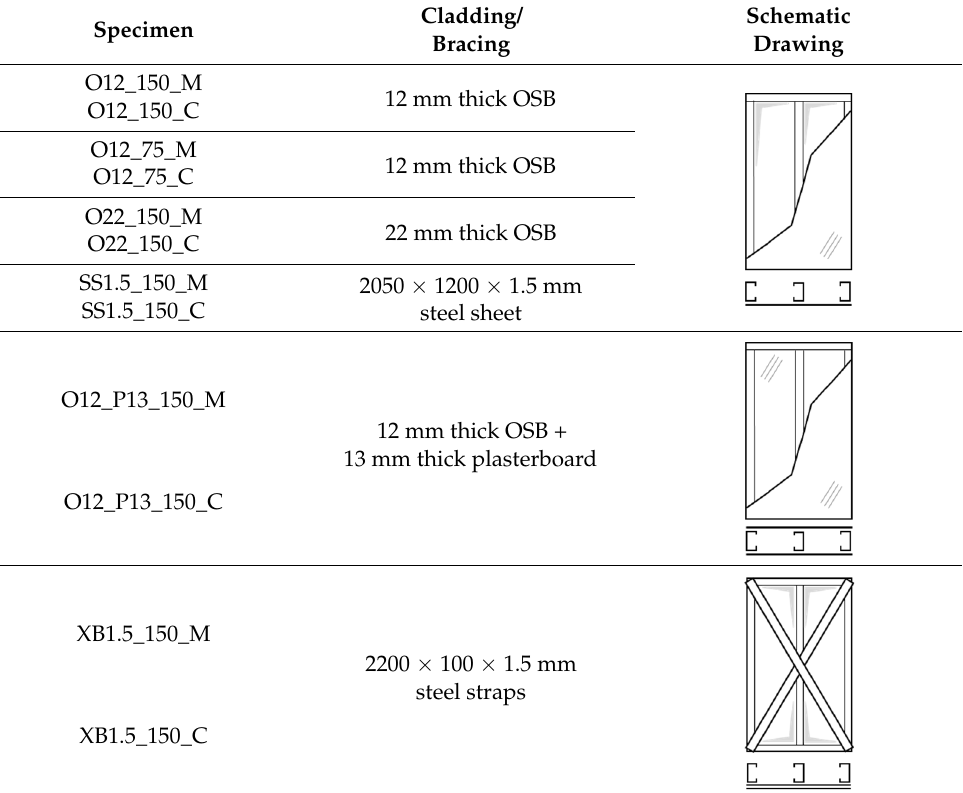
Table 1. Details and labeling of the tested walls.